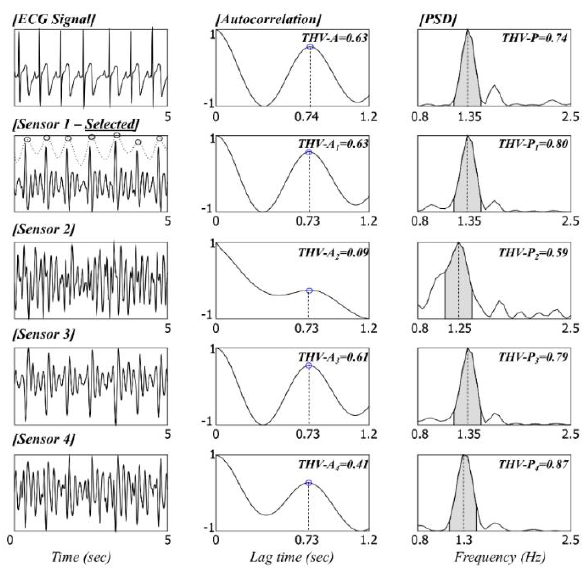
Figure 7. Signal quality check based on the THV-S and sensor selection for HR analysis. Sensors 2016 , 16 , 409